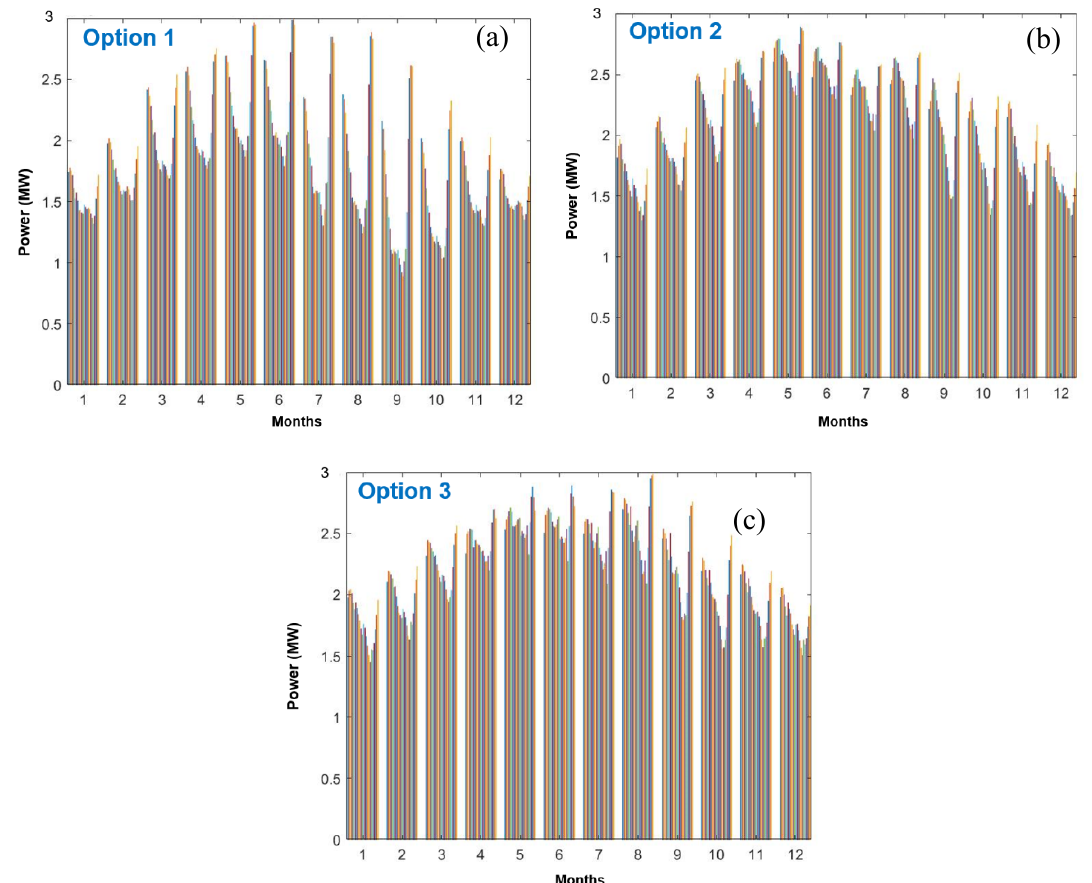
Figure 17. Average hourly power output per month for one wind turbine in three locations under consideration. (a) Option 1. (b) Option 2. (c) Option 3.